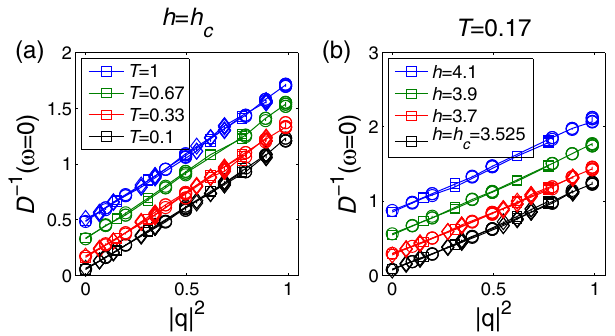
FIG. 7. Quadratic momentum dependence of the inverse nematic correlator at zero frequency. (a) D − 1 versus j q j 2 for all orientations of q , at h ¼ h and various temperatures. (b) The c same for fixed temperature T ¼ 0 . 17 t and a variety of values of FIG. 9. Nematic and quadrupolar susceptibilities versus inverse the quantum tuning parameter h . In each case the momentum temperature at h ¼ h . Multiple system sizes are shown with c dependence remains quadratic. Momenta from multiple system squares for L ¼ 16 , circles for L ¼ 20 , and diamonds for L ¼ 24 . sizes (represented by squares for L ¼ 16 , circles for L ¼ 20 , and The error bars reflect uncertainties due to finite system sizes, diamonds for L ¼ 24 ) fall on the same curve, indicating that the estimated from the differences between the measured suscep- properties shown are in the thermodynamic limit. tibilities of systems with different boundary